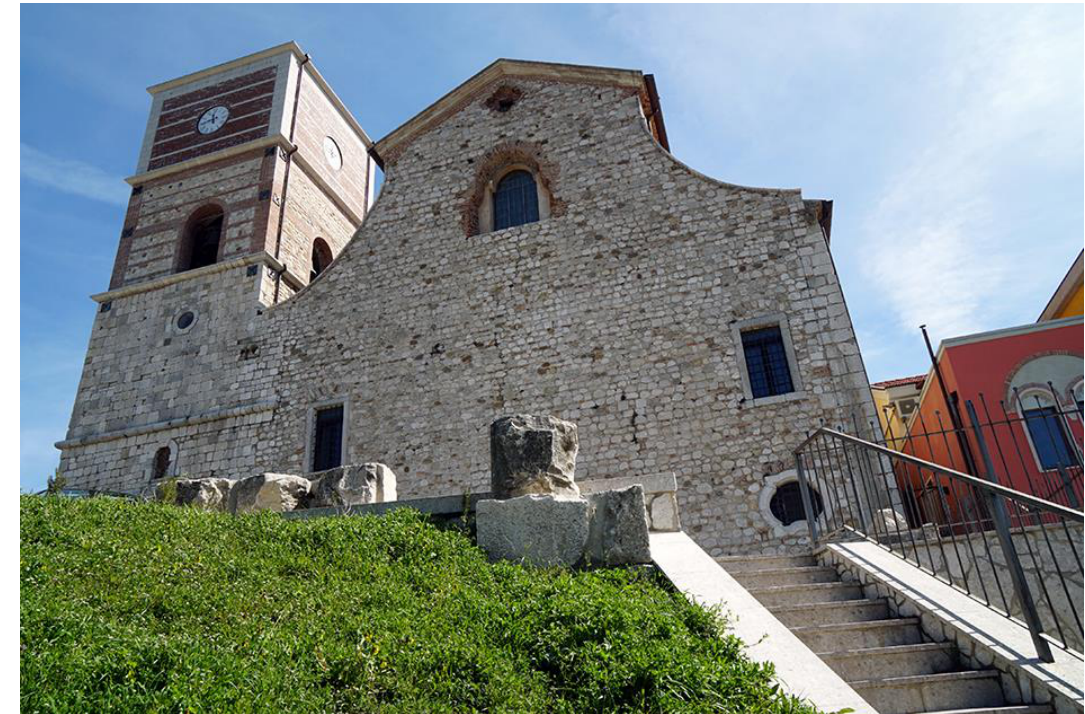
Figure 37. Sant’Angelo dei Lombardi: Archdiocese of Sant’Angelo dei Lombardi in the historical center: (photos by [35,36]).